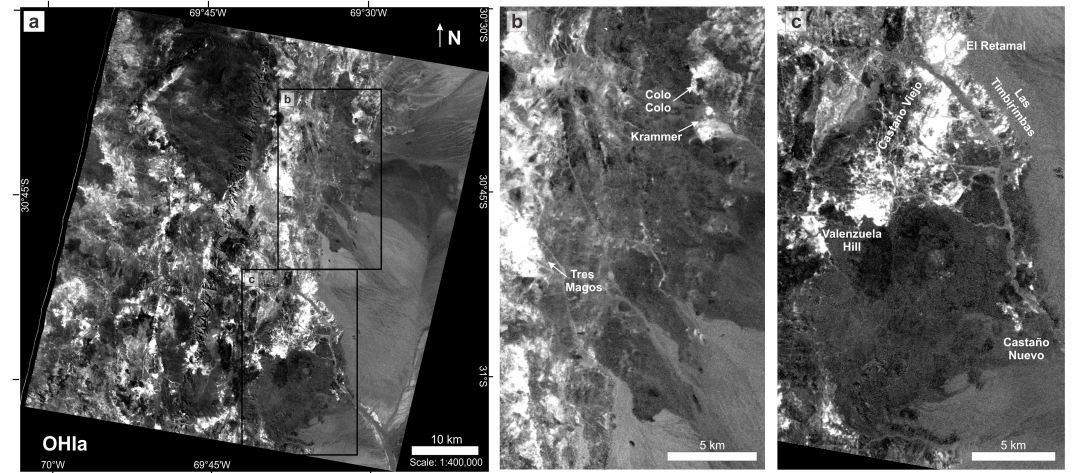
Figure 10. ( a ) OH-bearing minerals index image (OHIa), the white zones represent areas where it is more likely to find phyllosilicates. ( b ) The Tres Magos, Krammer and Colo-Colo alteration zones are highlighted white. ( c ) The NNE-trending Castaño Viejo alteration zone (from Valenzuela Hill to El Retamal and Las Timbirimbas) and the more restricted Castaño Nuevo alteration zone are detected in white.